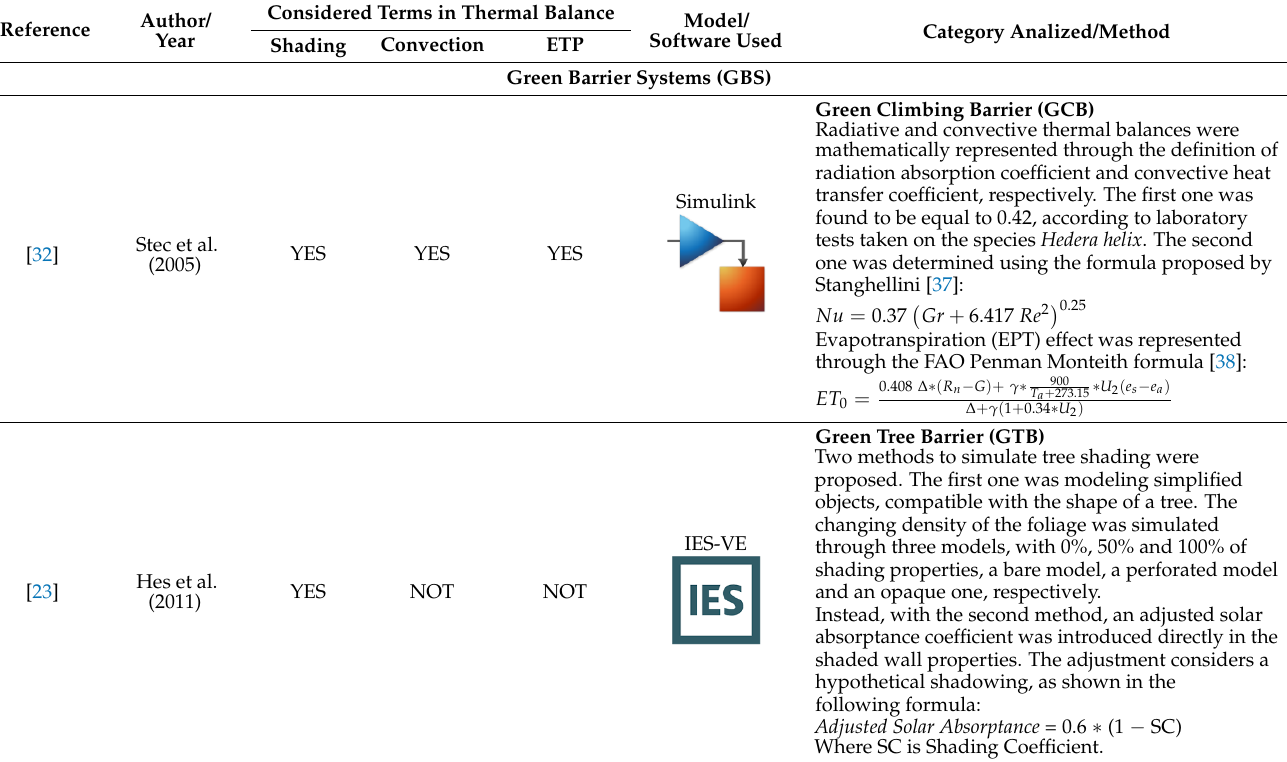
Table 1. Studies about VGS divided into the three categories defined. The VGS effects on buildings considered in each study are specified.